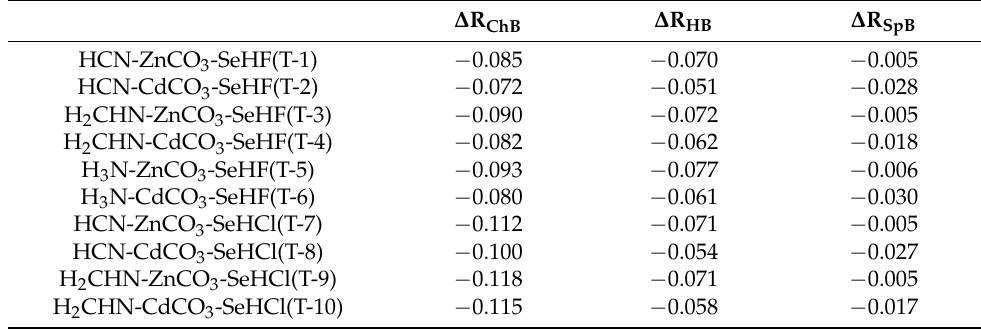
∆ R ∆ R ∆ R HB SpB ChB